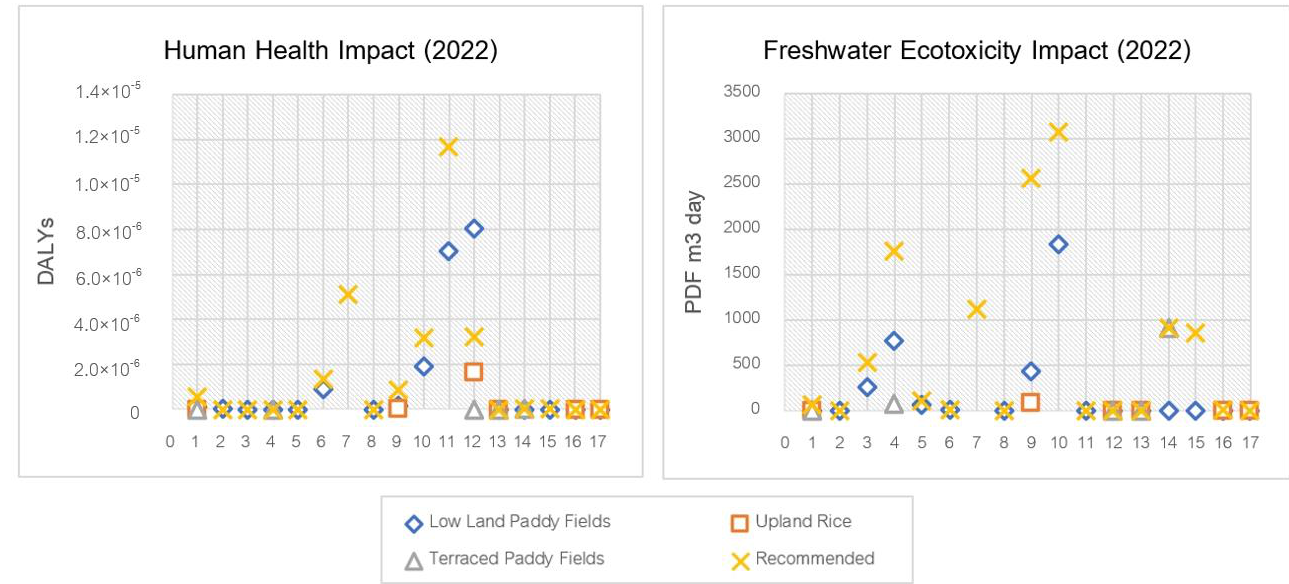
Figure 4 . Human health and ecotoxicity impact scores on pesticide use in rice cultivation in 2022 . 1 . Chlorpyrifos, 2 . Glyphosate, 3 . Acephate, 4 . Alachlor, 5 . Butachlor, 6 . 2,4 - D dimethyl ammonium, 7 . Fipronil, 8 . Metaldehyde, 9 . Mancozeb, 10 . Atrazine, 11 . Atrazine ( cancer ) , 12 . Acephate, 13 . Acephate ( cancer ) , 14 . Carbendazim, 15 . Cypermethrin, 16 . Captan, and 17 . Captan ( cancer ).